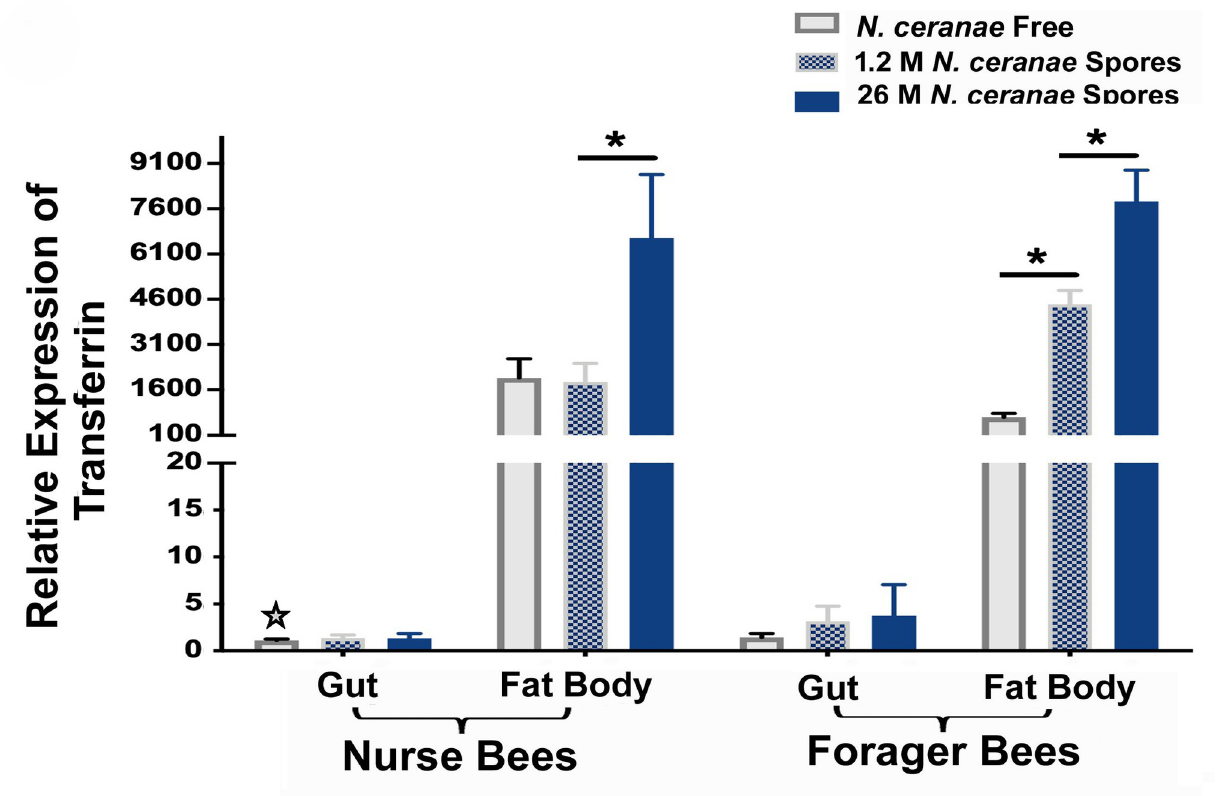
Fig 5. Tissue-specific relative transferrin mRNA transcript level in gut and fat body tissues of nurse forager bees. The relative expression was expressed as an n-fold difference relative to the calibrator (marked by a star) by 2 – ΔΔ Ct method. A star denotes a calibrator and an asterisk ( � ) denotes a statistically significant difference between the two groups ( P �